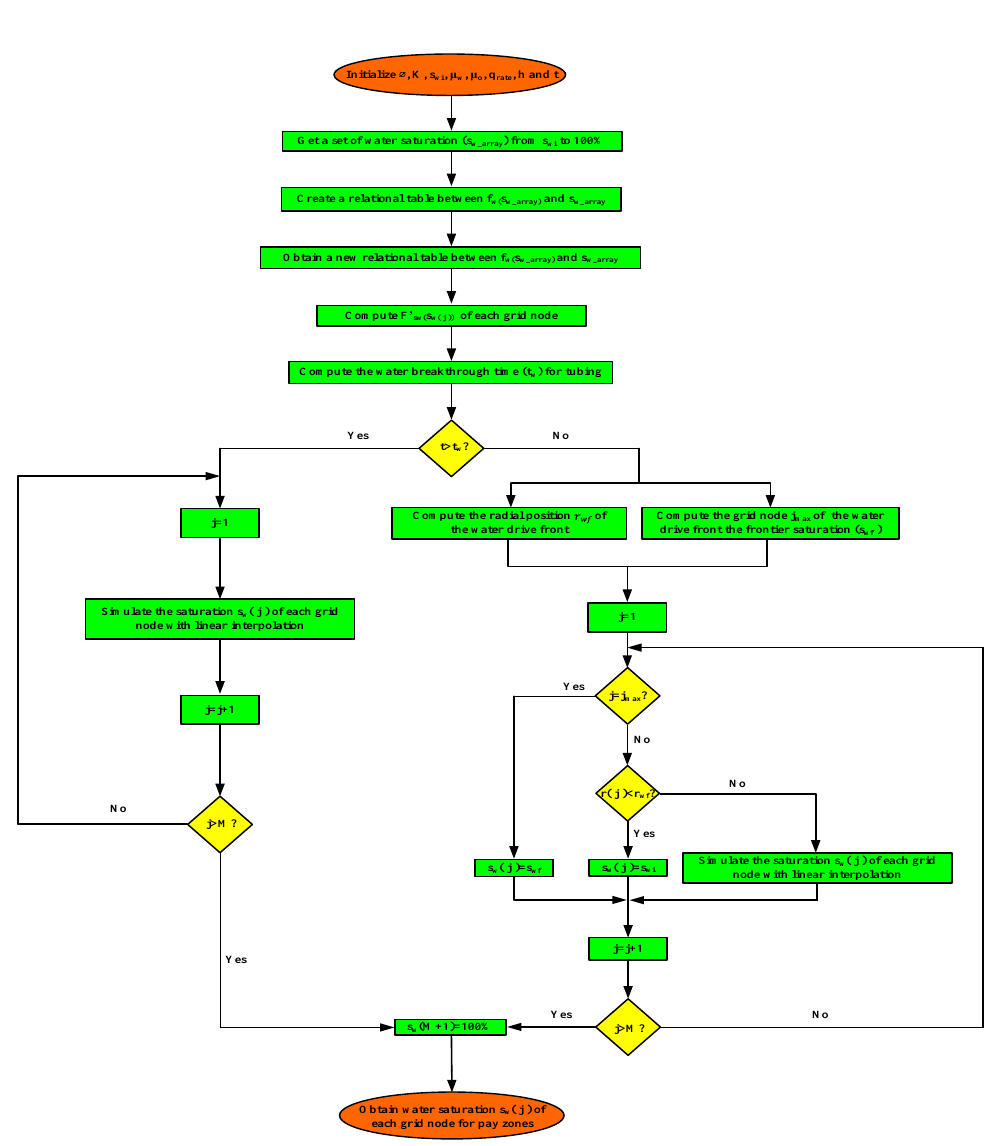
Figure 6. Flow chart of water saturation calculation for pay zones.